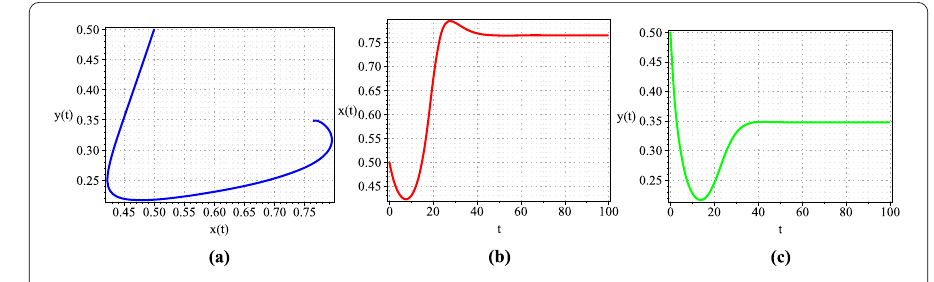
Figure 6 Numerical simulations without impulsive. ( a ) Phase portrait of x ( t ) and y ( t ). ( b ) Time series of x ( t ). ( c ) Time series of y ( t )